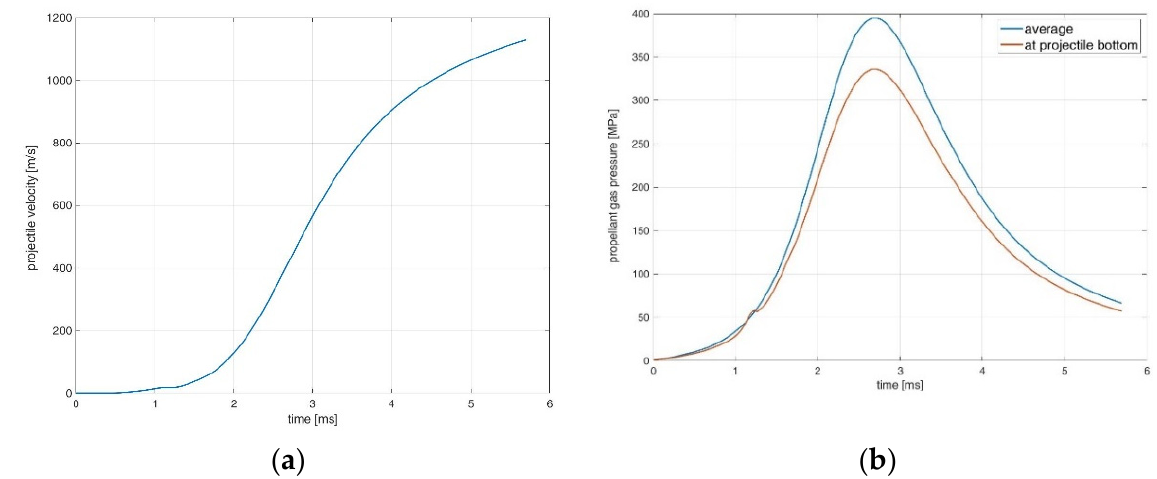
Figure 13. Ballistic curves (as function of time), ( a )—projectile velocity, ( b )—propellant gas pressure.